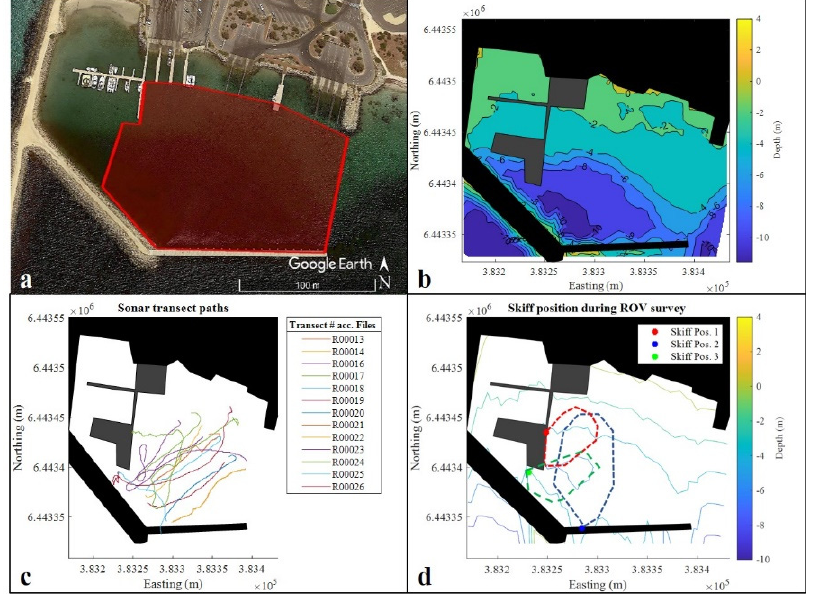
Figure 2. ( a ) Testsite in Woodman Harbour (Western Australia) marked by the red polygon; ( b ) bathymetry map of Northern Harbour generated from LIDAR data; data provided by [51]; ( c ) paths of the boat during the transects of the sonar survey according to file names; ( d ) boat position during remotely operated vehicle (ROV) operation; estimated areas of ROV operations are marked by polygons.